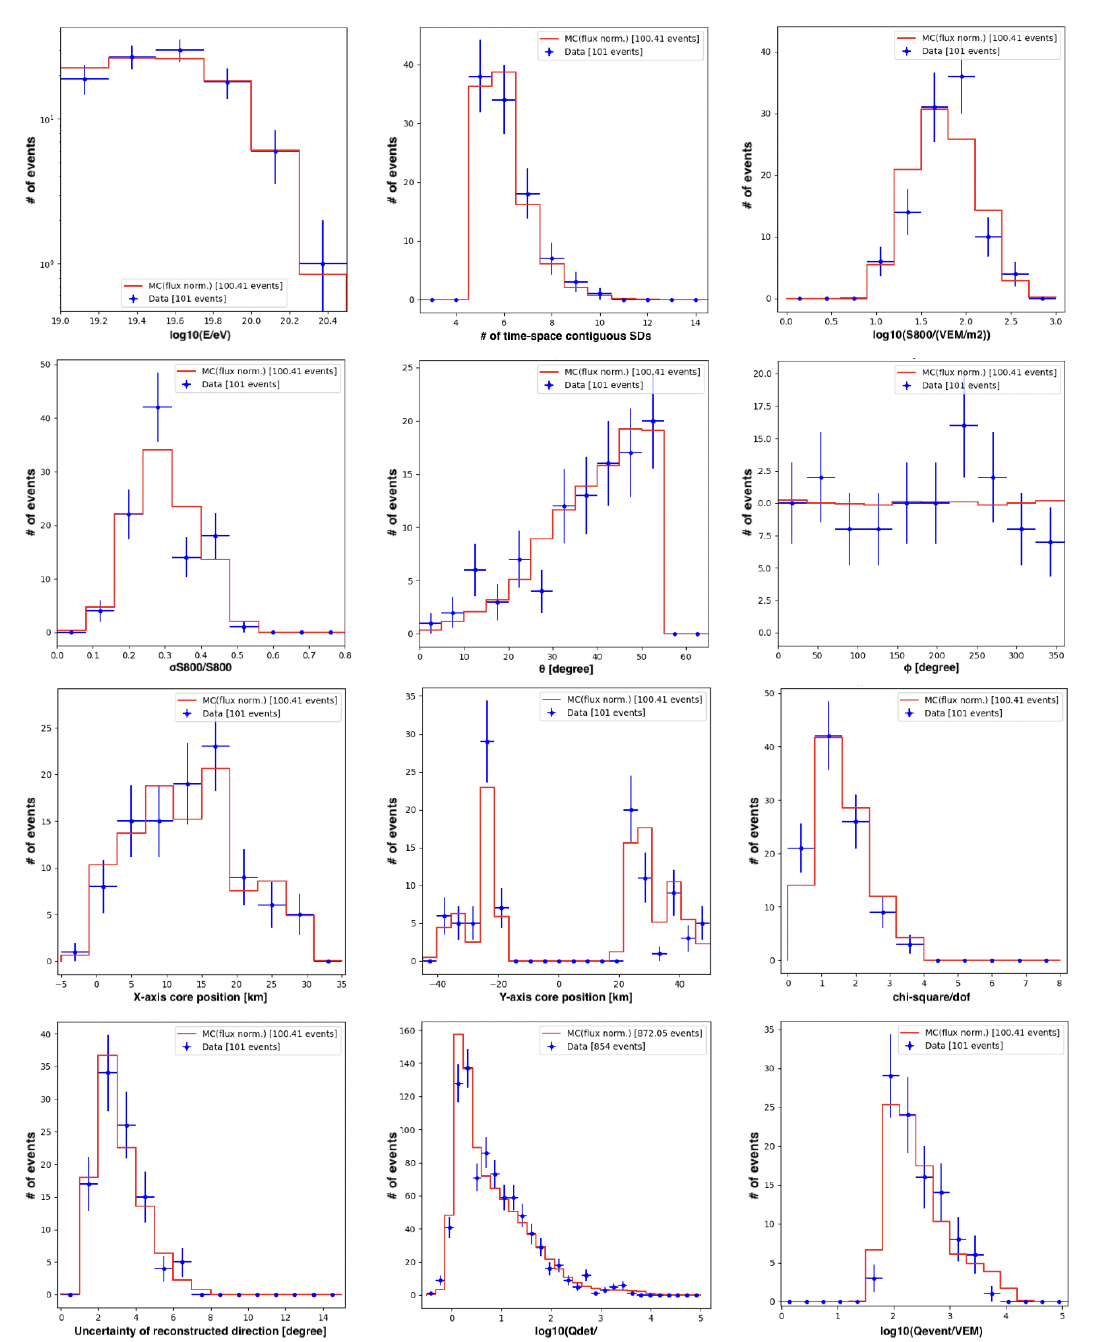
Figure 3: Comparisons between observed data (blue points) and MC simulation (red histogram). MC simulation histogram is normalized in terms of the number of expected events as explained in section 3.2 with 1.3 as an energy scaling factor. KS test p-values of the parameters are listed in Table1. The compared parameters are reconstructed energy, the number / S 800 , zenith angle, azimuthal angle, core positions (west-east direction and south-north direction), of hit SDs, S 800 , σ S 800 χ 2 / ndof of fit, uncertainty of reconstructed direction, signal per one SD and signal per one event. The Monte Carlo distributions are in good agreement with the